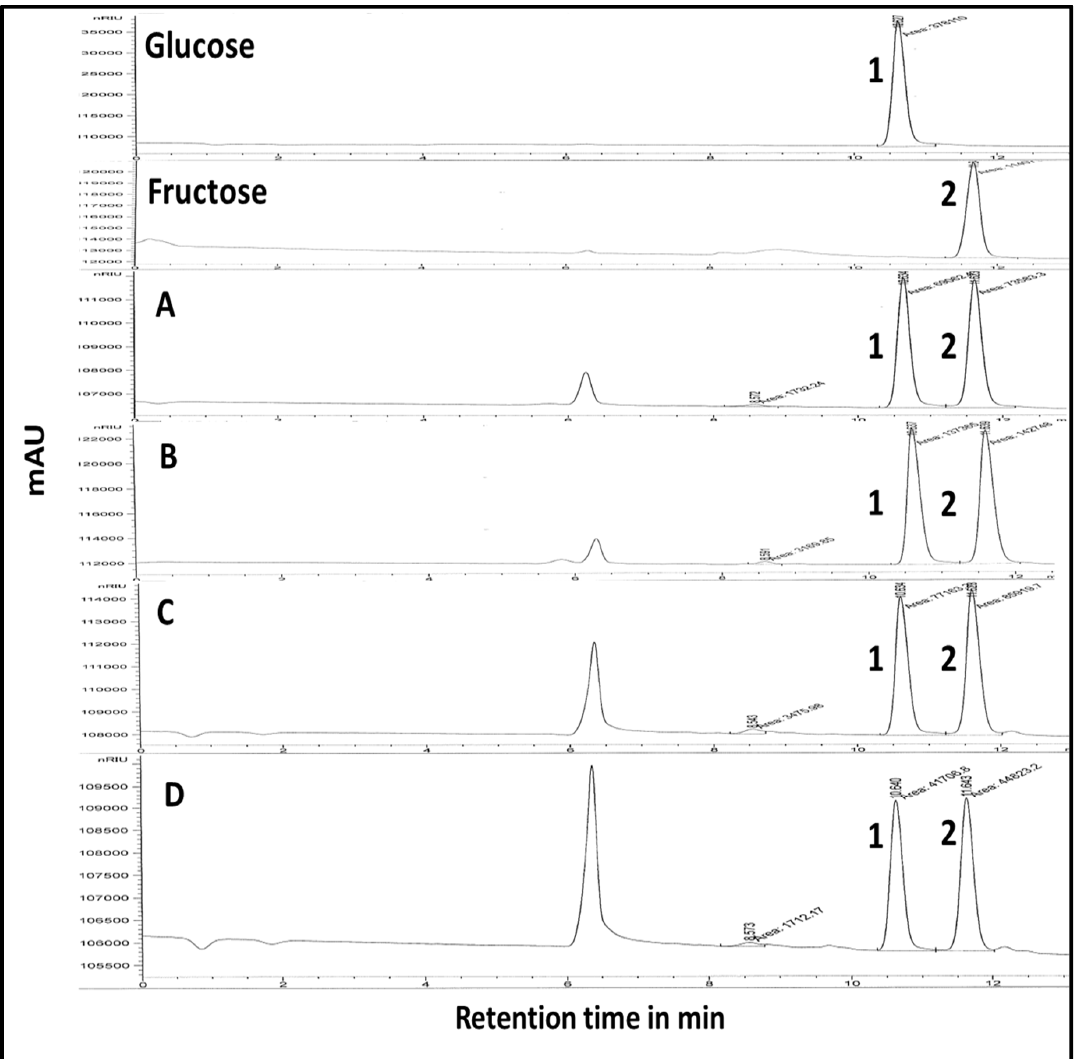
Figure 6. HPLC–RI chromatograms of the sugars of standard (glucose, RT = 10.62 min; fructose, RT = 11.64 min) and ripe fruit grown in Indonesia ( A ), Malaysia ( B ), Egypt ( C ) and unripe from Egypt ( D ).